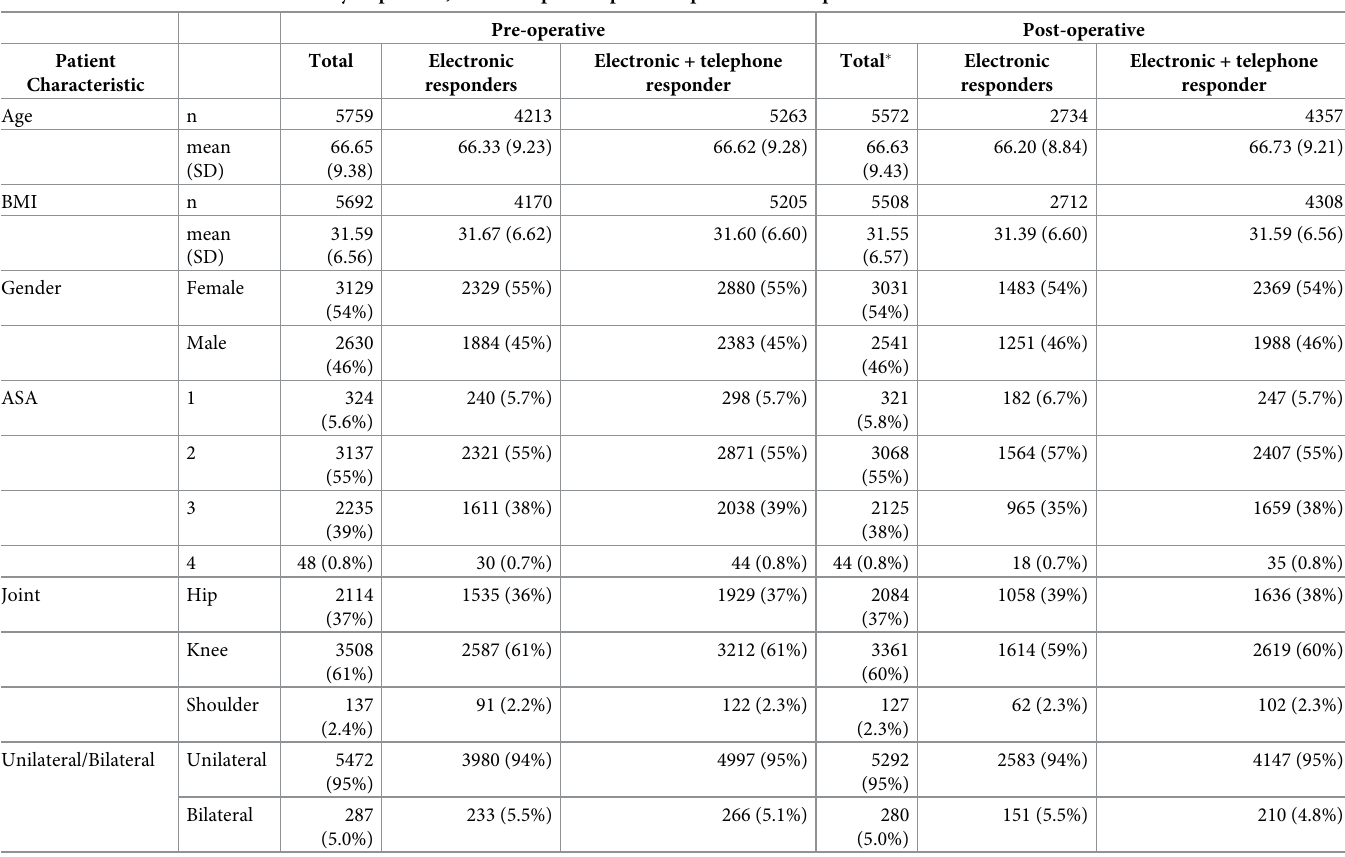
Table 3. Characteristics of electronic-only responders, electronic plus telephone responders and all